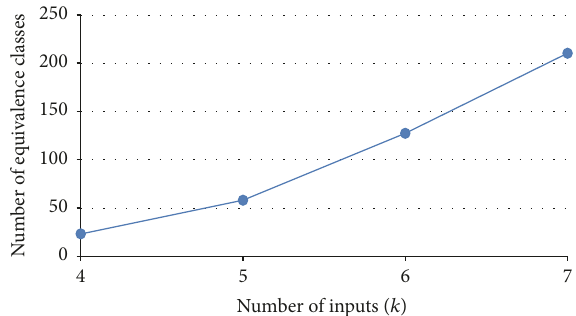
Figure 4: Number of used NPN-equivalence classes for input size 𝑘 =